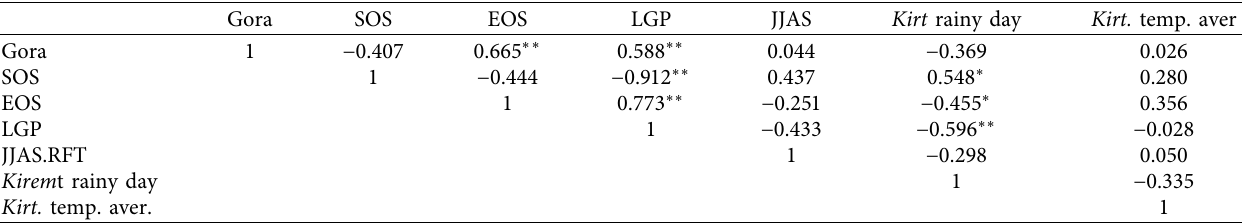
Table 6: Pearson’s upper triangular correlation matrix of Gora yields with seasonal rainfall and kiremt average of temperature char- acteristics at Welmera area.